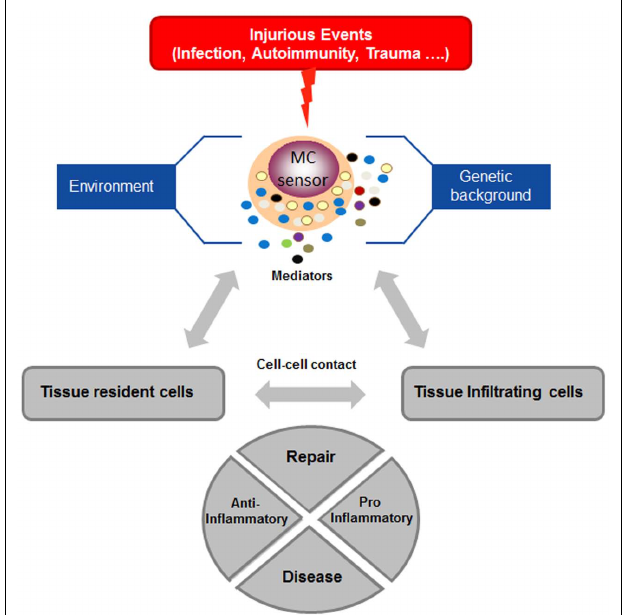
FIGURE 2 | Mast cells function as cellular sensors. Mast cells are components of the innate and adaptive immune surveillance system in tissues. Following an injurious event, mast cells become activated and release a whole array of pro-inflammatory mediators.Their activation will promote a tissue inflammatory response characterized by the cellular cross-talk with tissue resident cells and other tissue infiltrating cells through released products or direct cell–cell contact. Mast cell activation is controlled by multiple additional factors that highly depend on a given genetic background and the local environment. Studies in recent years have revealed that mast cells are able to differentially control this response by initiating either a pro- or anti-inflammatory program destined for tissue repair and conditioned by the nature of the initial injurious event (strength, type, etc., for explanation see text). Mast cells can therefore be viewed as cellular sensors that direct tissue responses in inflammation and immunity as a function of the stimulus and physiological/pathological context. Dysregulation of this sensor function by chronic stimulation or defective control mechanisms can promote pathology and lead to inflammatory and auto-immune